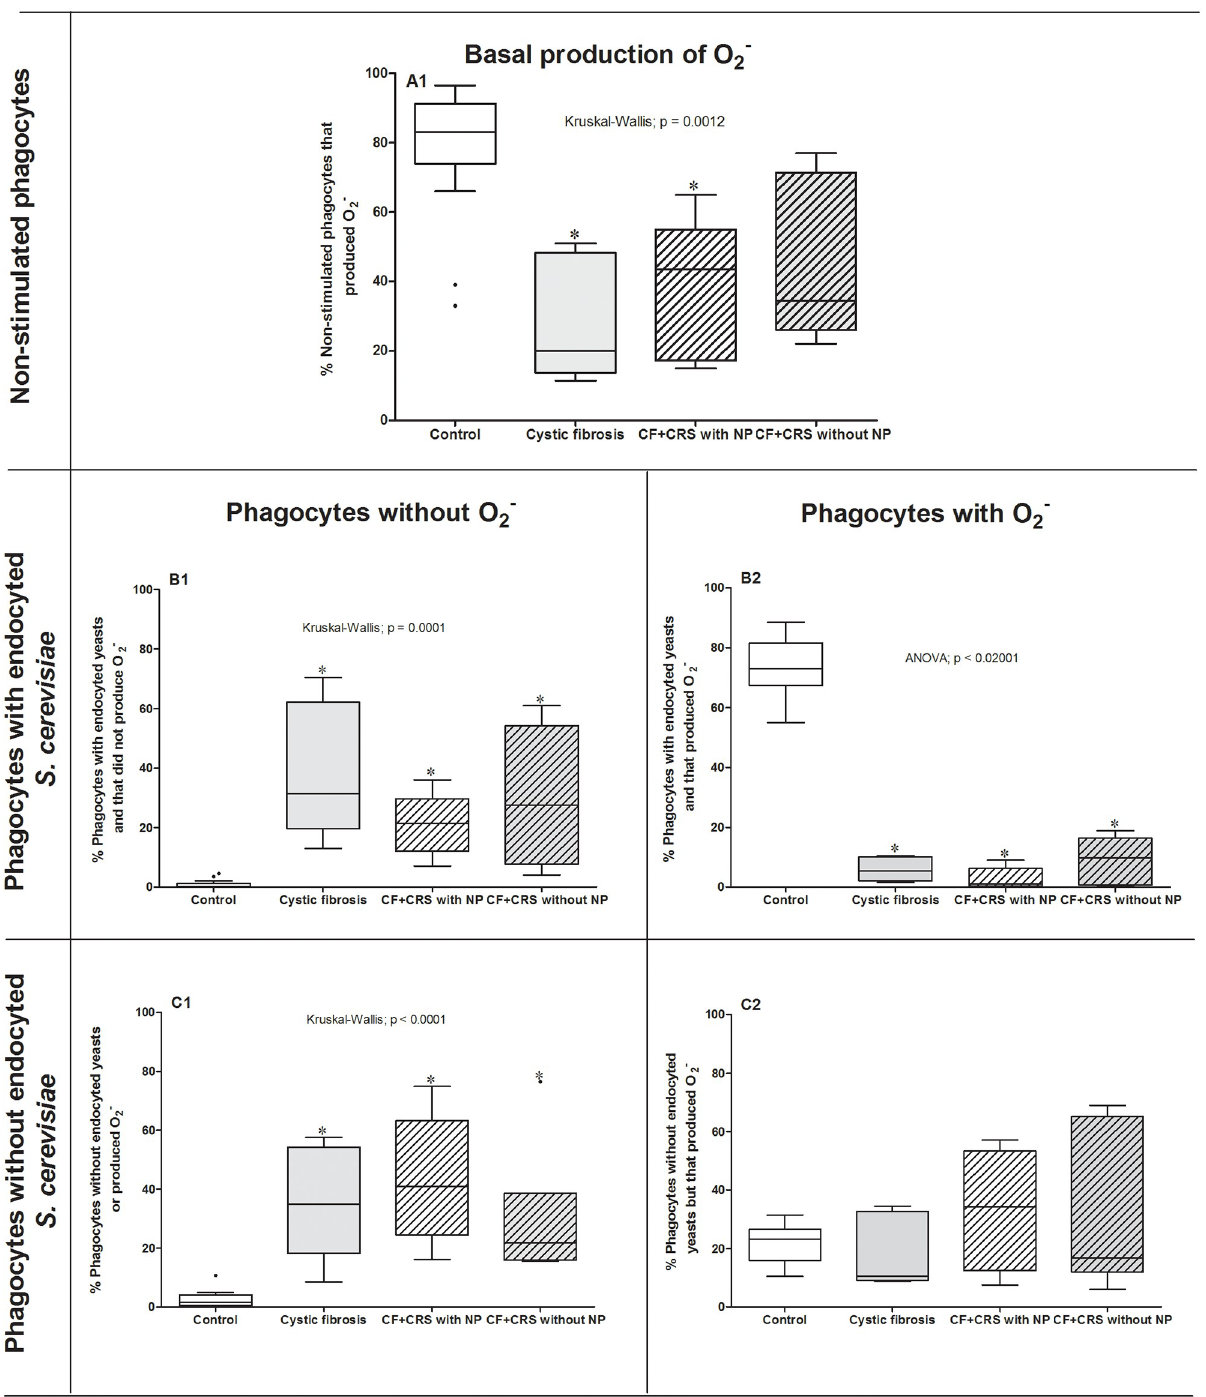
Fig 3. Superoxide anion production. Percentage of reduction of nitro blue tetrazolium by phagocytes obtained from peripheral blood of the control group (n = 14), cystic fibrosis group (CF; n = 5), cystic fibrosis + chronic rhinosinusitis with polyps group (CF+CRS with NP; n = 5), and cystic fibrosis + rhinosinusitis without polyps group (CF+CRS without NP; n = 6). Phagocytes were incubated with and without Saccharomyces cerevisiae yeasts to either stimulate or not stimulate superoxide anion production. Significant results are shown by � between groups. Values are presented as the median, quartiles, maximum, and minimum